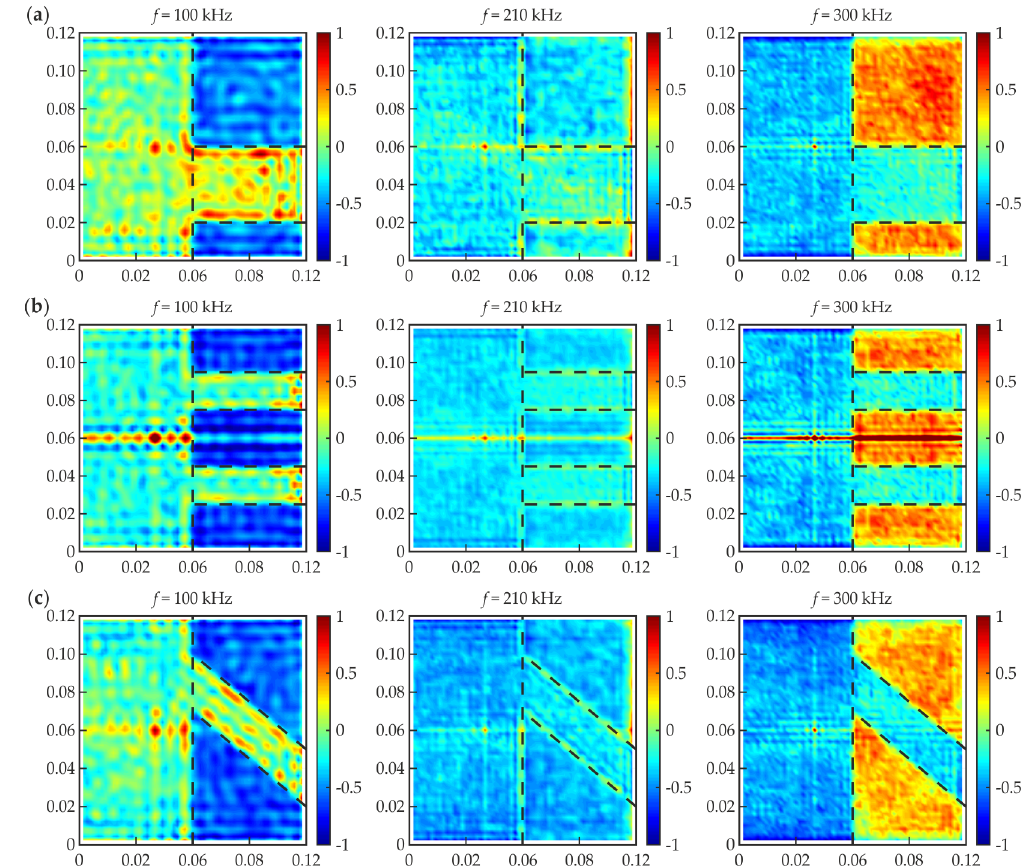
Figure 12. Numerical RMS maps for different excitation frequencies (100, 210, and 300 kHz) and different defects: ( a ) #2; ( b ) #3; and ( c ) #4.